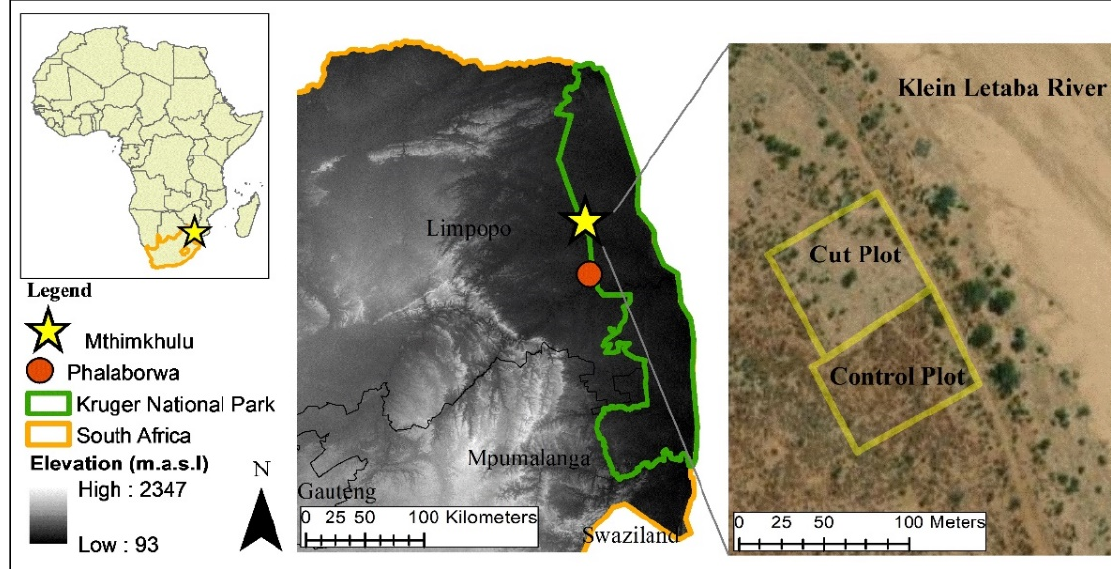
Figure 1. Location of the Mthimkhulu Game Reserve in the Limpopo Province, north-eastern South Africa, and the location of the control and cut plots within the reserve.